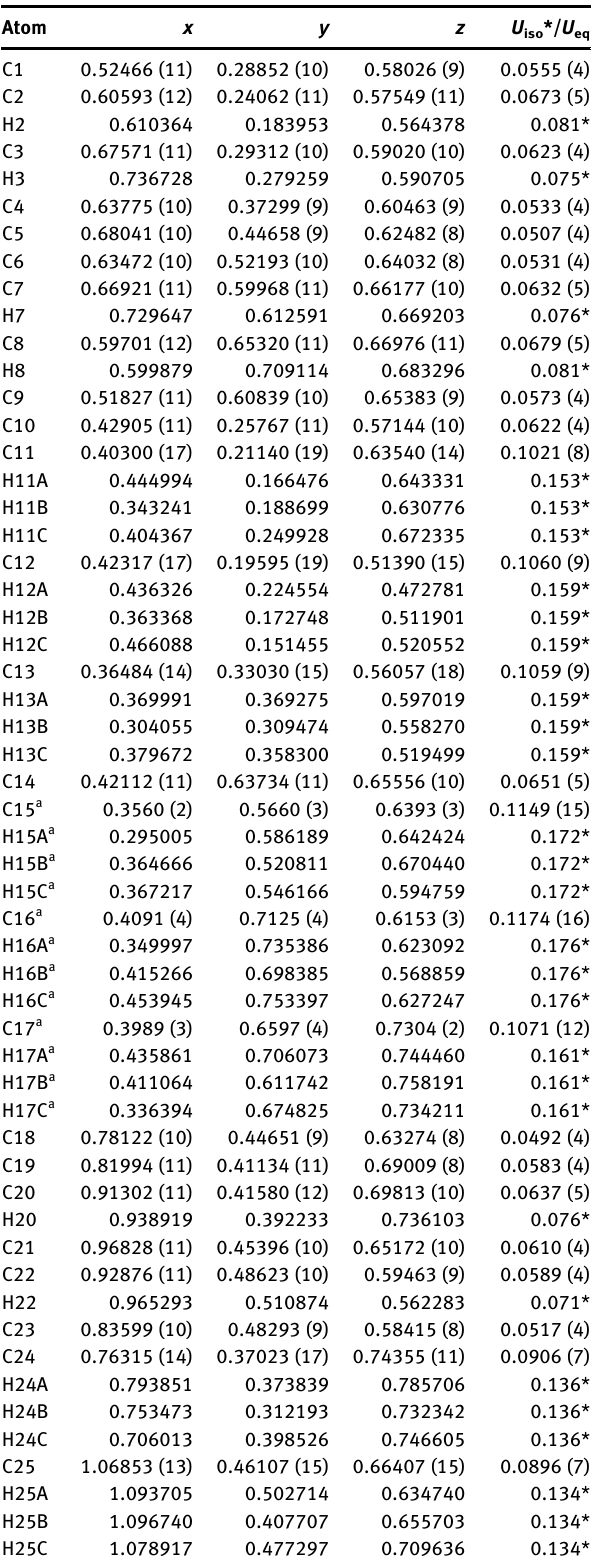
Table  : Fractional atomic coordinates and isotropic or equivalent isotropic displacement parameters (Å 